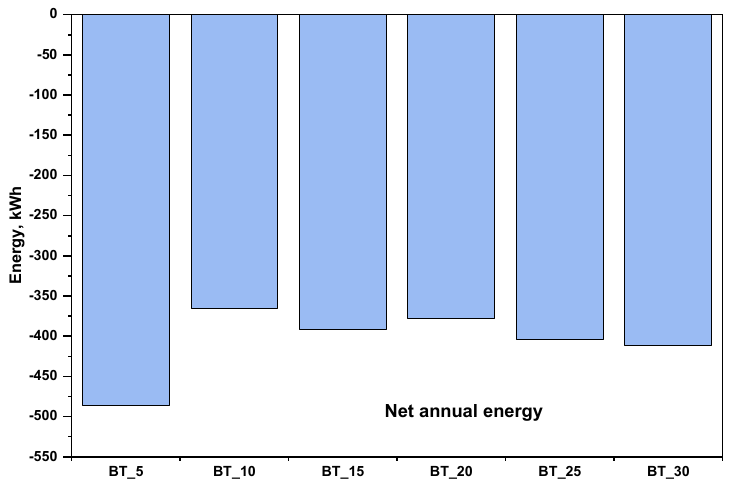
Figure 13. The net annual energy for different battery capacities.